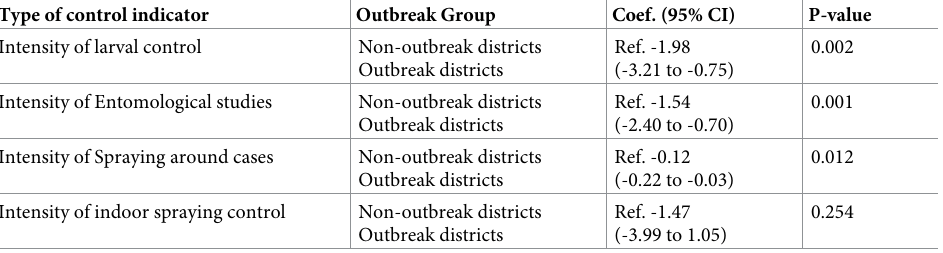
Table 2. Mix-effect linear regression and GEE of the association between the intensity of different types of vector control and outbreak/non-outbreak